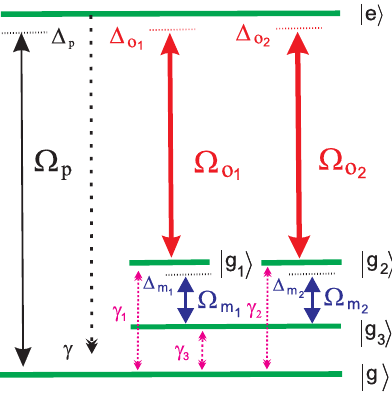
Figure 1. (Color online) Schematics of the atomic system